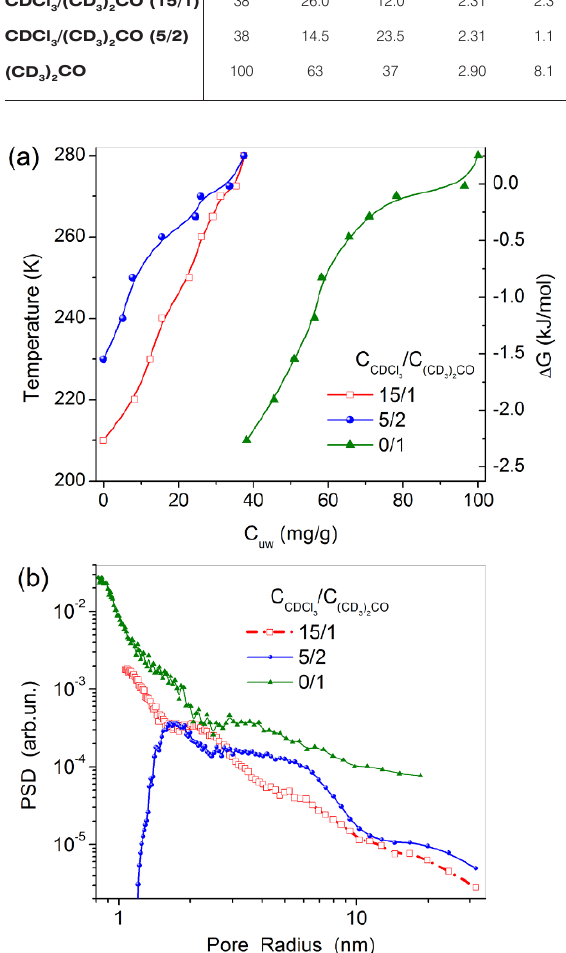
Figure 6. (a) Temperature dependences of the amounts of unfrozen water C (T) and the relationship between uw C and ∆ G for water bound to NC in chloroform-d/ uw acetone-d medium (their ratio is 15/1 and 5/2) at 6 h = 38 mg g -1 , and in acetone-d at h=100 mg g -1 . 6 (b) Size distribution of water structures or sizes of pores in NC filled by unfrozen water.